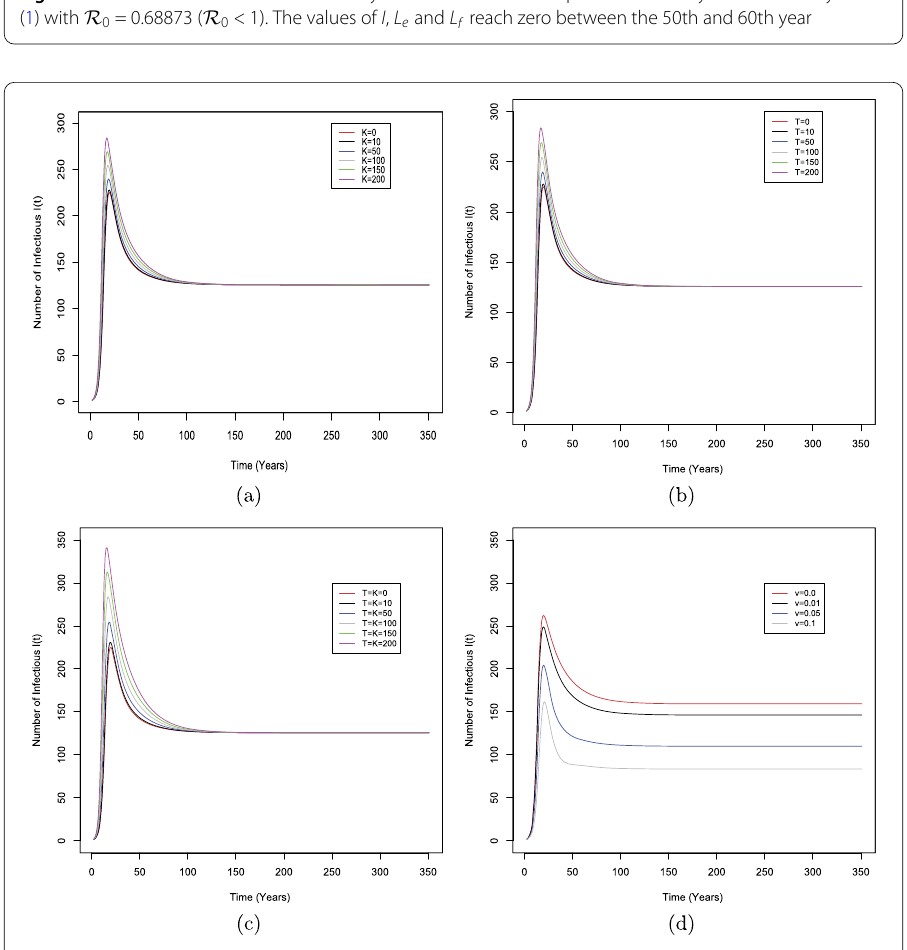
Figure 4 Evolution of the model with R 0 > 1. ( a ) and ( b ) present the evolution of the compartment I ( t ) for several values of K and T for v = 0.030 and β = 0.010. With the same parameters ( c ) shows the evolution of the compartment I ( t ) when T and K are considered simultaneously. In ( d ) there are several values of v considered to see the evolution of I over